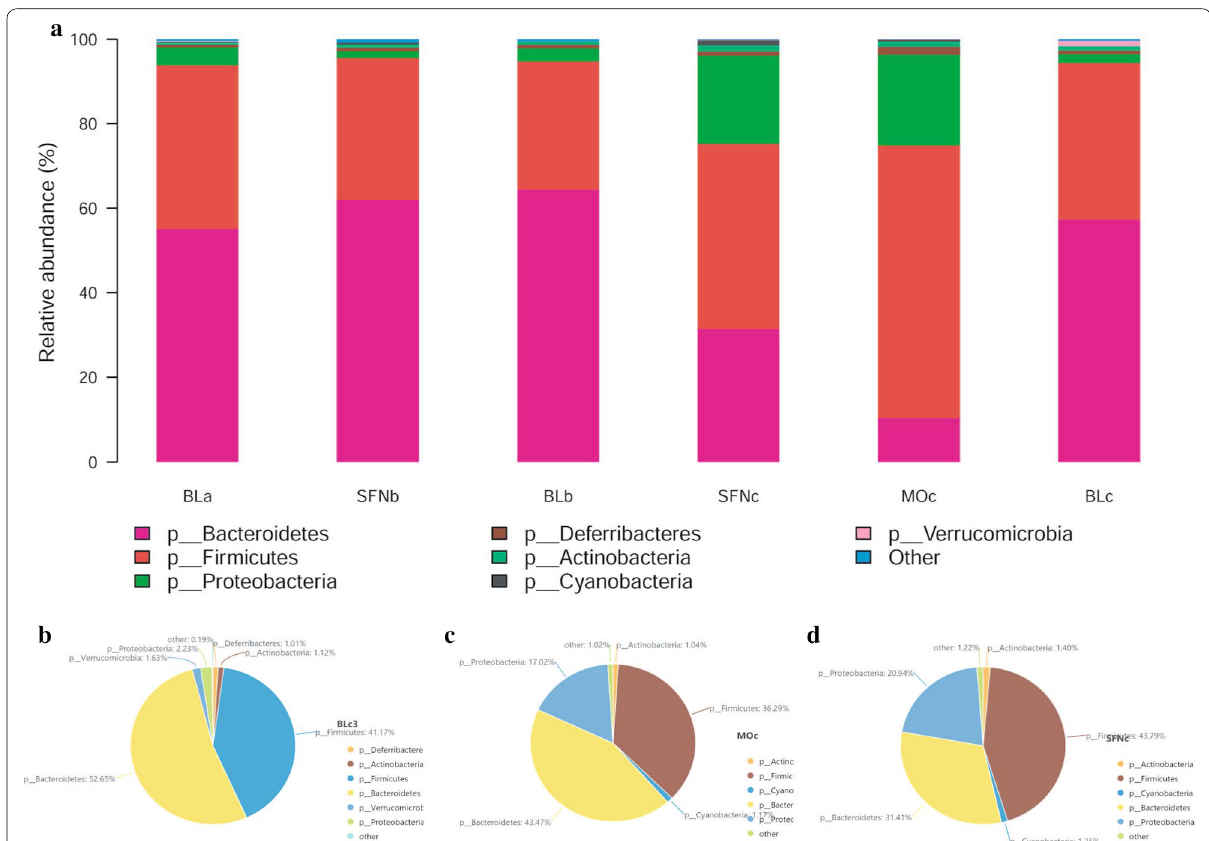
Fig. 4 SFN modulated the composition of gut microbiota at the phylum level. a Phylum-level taxonomic distributions of the microbial communities in feces. b – d Composition of the phylum level in the 14th day in three